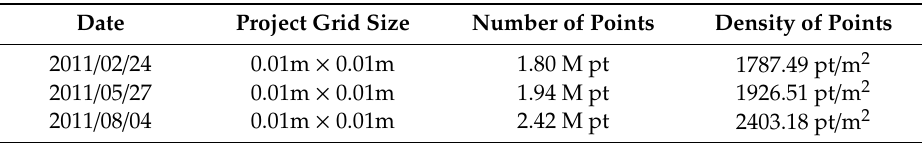
Table 1. The results of three ground scans in